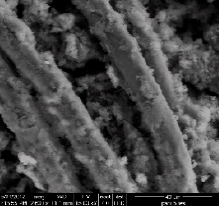
Figure 1. SEM image of polyester textile coated with